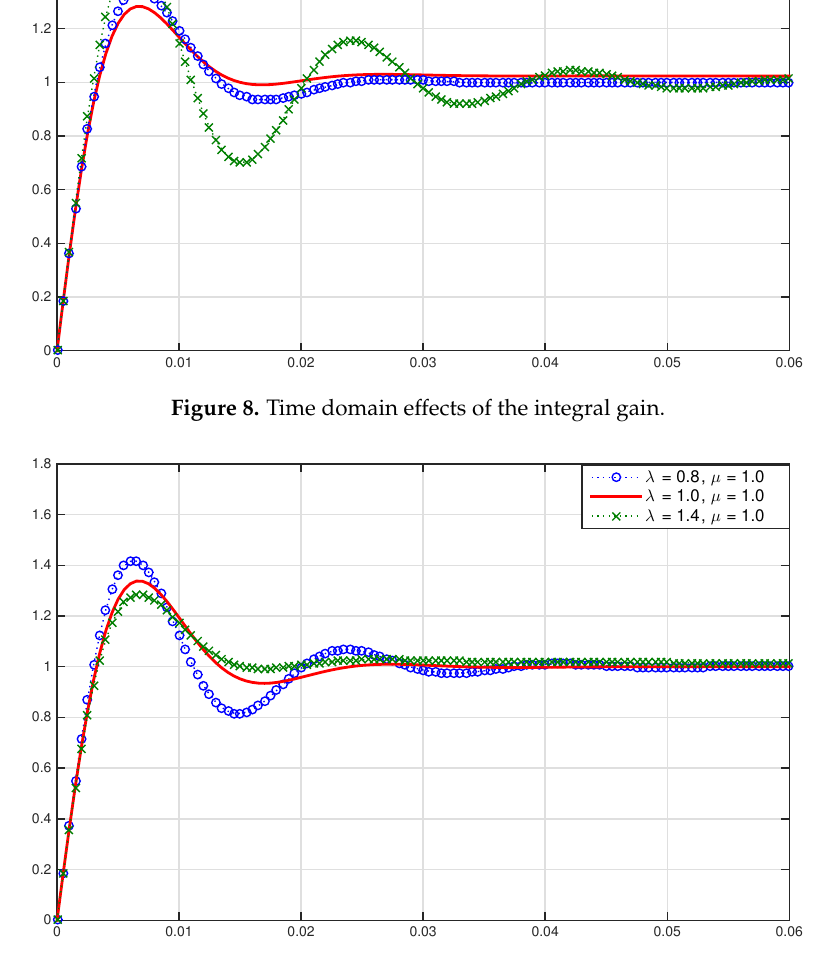
Figure 9. Time domain effects of the fractional integral order.